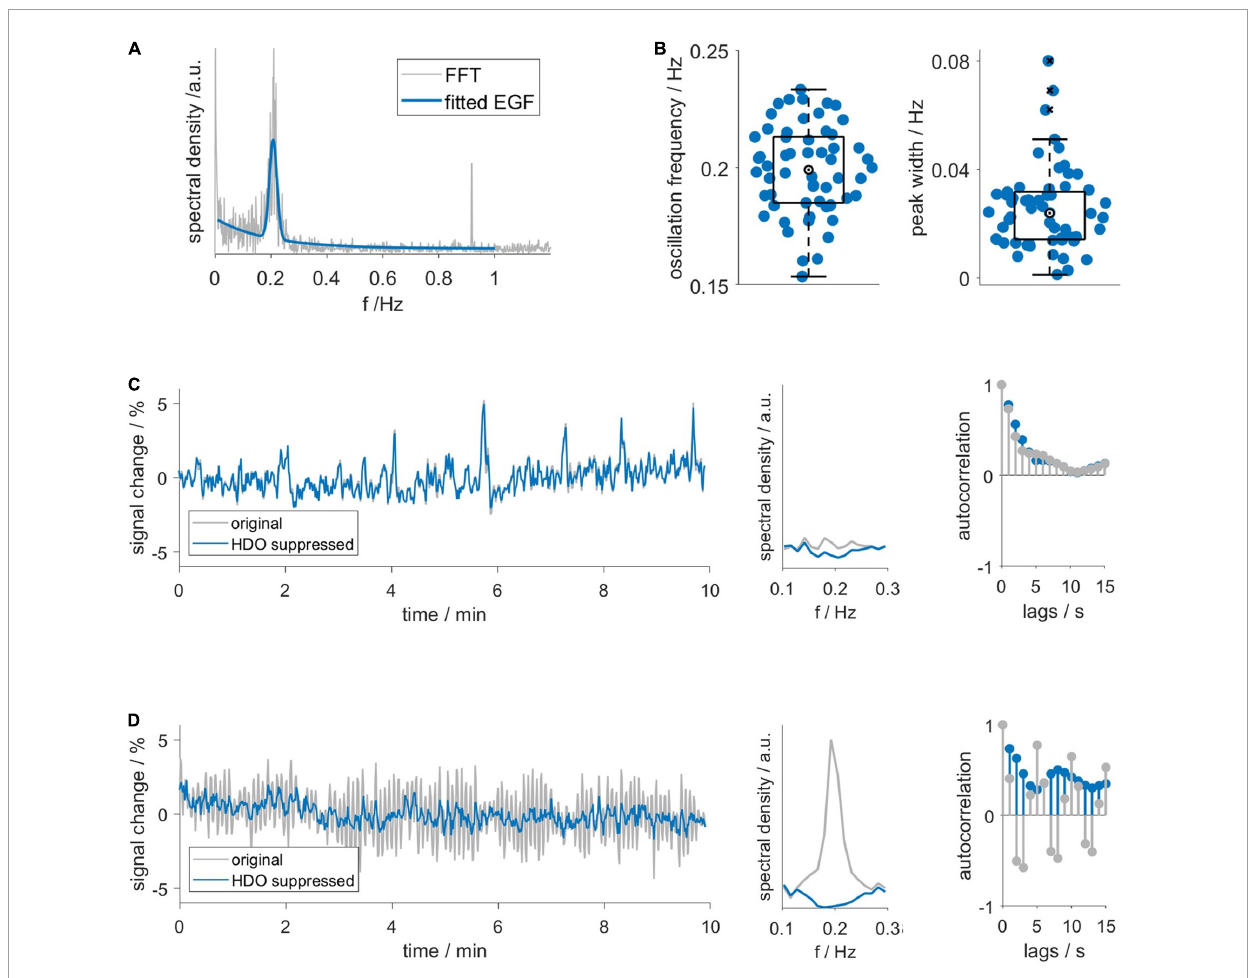
FIGURE3 Hemodynamic oscillations frequency and assessment of suppression algorithm performance. (A) An exponential-gaussian function (EGF, blue) was fitted to FFT (gray) of an exemplary GE-EPI time course. Note that respiration caused a peak at 0.9 Hz. (B) HDO frequency f o and peak width σ , resulting from fitting 58 spectra. Representative (C) non-oscillatory and (D) oscillatory datasets: time courses (left), spectra (middle) and autocorrelation functions (right) before (gray) and after (blue) application of the HDO suppression algorithm. In contrast to the non-oscillatory dataset, the spectrum of the oscillating dataset showed a peak and the autocorrelation function showed a periodic pattern. The suppression algorithm eliminated HDO without substantially affecting non-oscillating